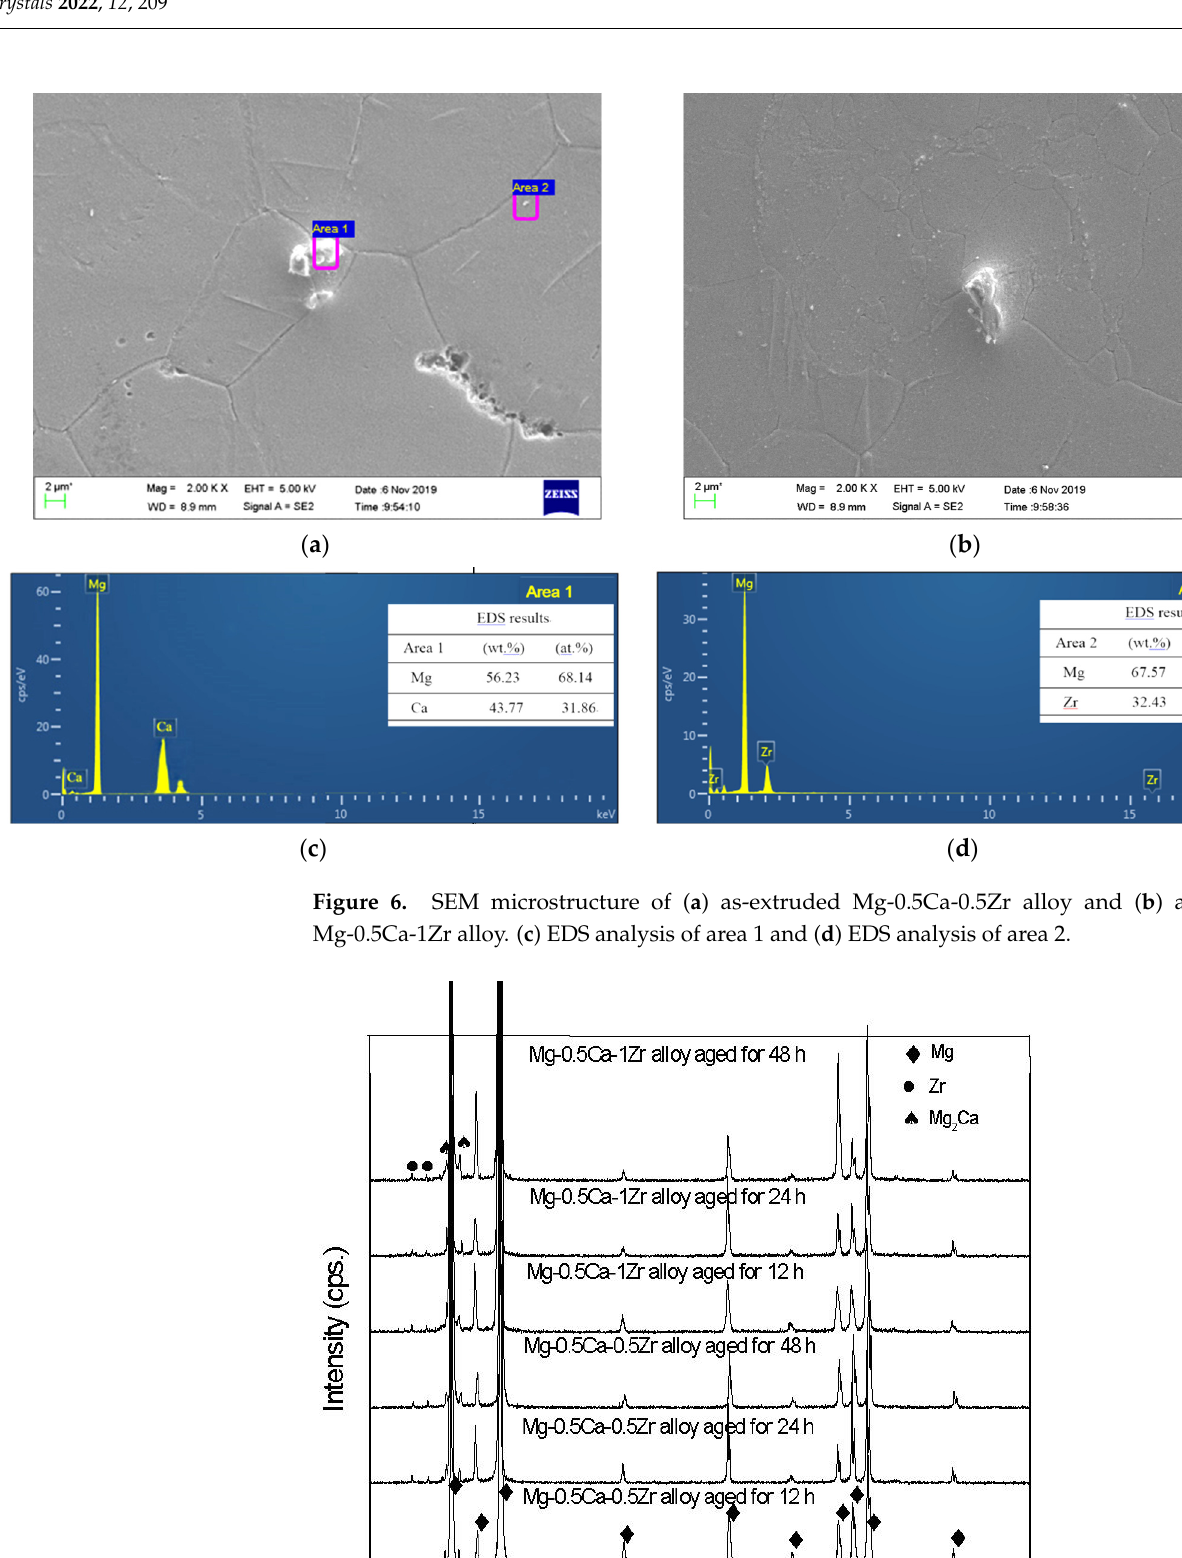
Figure 5. ( a ) SEM microstructure of as-cast Mg-0.5Ca-0.5Zr alloy, ( b ) EDS analysis of area 1, ( c )